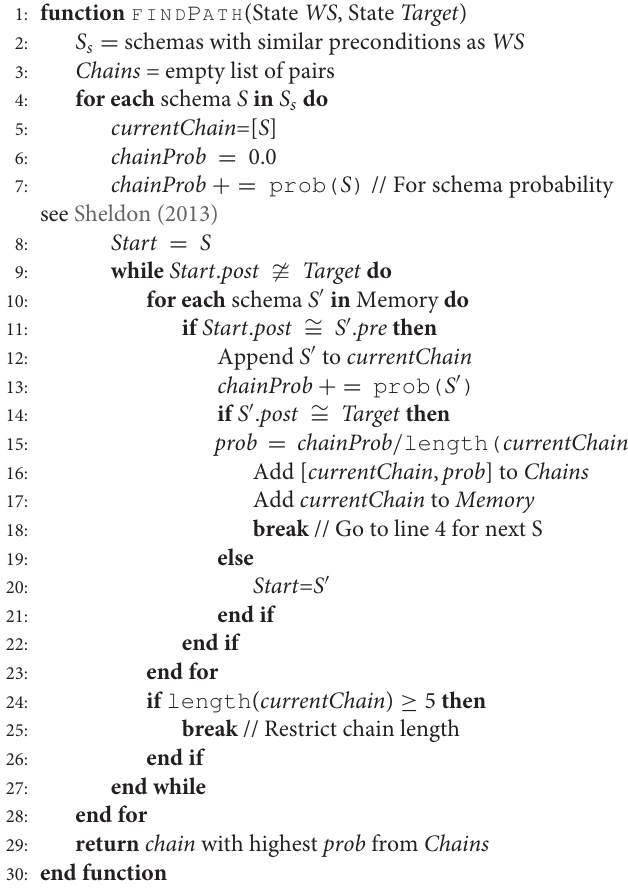
Algorithm 1 Excitation Calculation Algorithm 2 Schema chain calculation